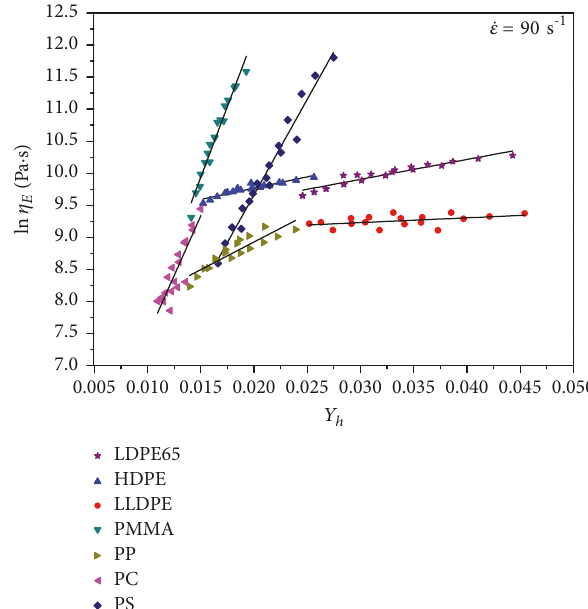
Figure 5: The logarithm of viscosity at 90 s - 1 elongational rate versus 𝑌 ℎ . The solid line is the best fit line through each data set by (7) and (8) with the parameters tabulated in Table